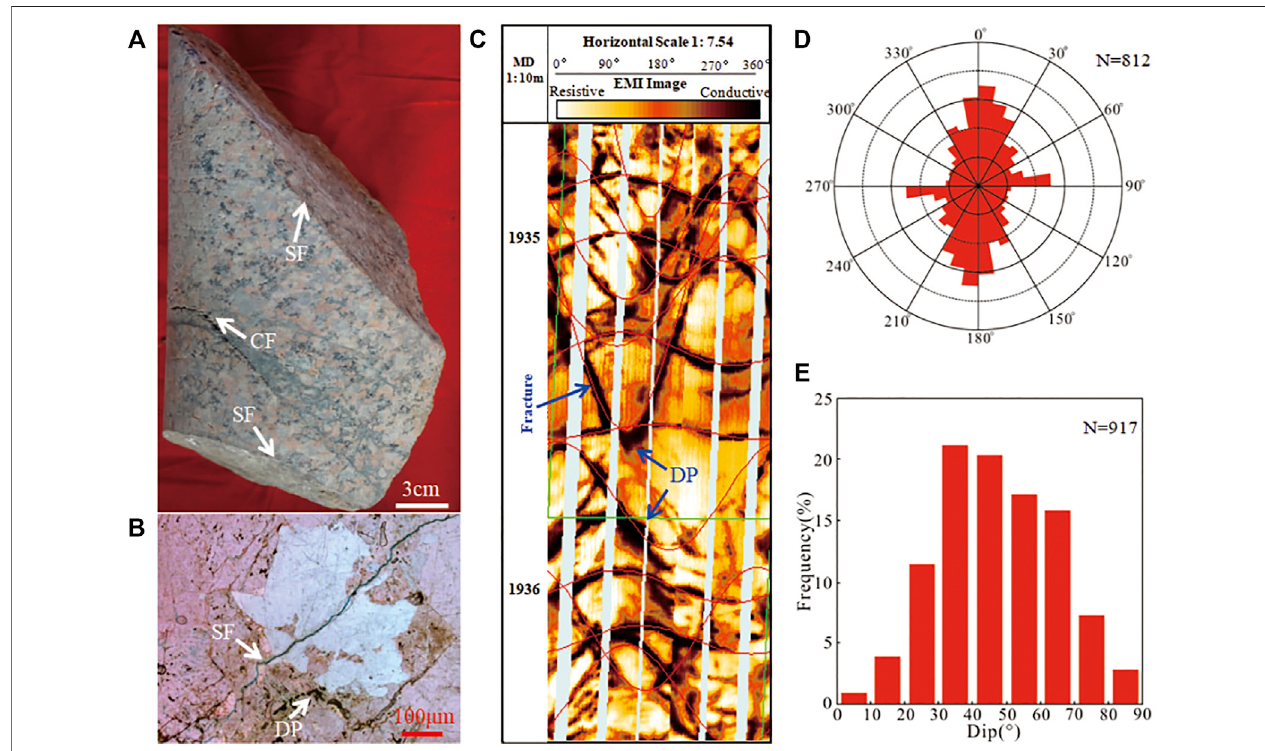
FIGURE 4 | Fracture development on cores and FMI image. (A) A group of fractures in granite. Well W2: depth 2,104.2 m. SF is shear fracture, CF is corrosion fracture. (B) Thin section showing shear fracture in granite. Well W18: depth 2,128.3 m. DP is dissolution pore. (C) Network fractures in FMI image of Well W5. (D) Rose diagrams of natural fracture strike in granite from FMI. (E) Dip angles of natural fracture in granite from FMI and cores. See Figure 1 for wells location.